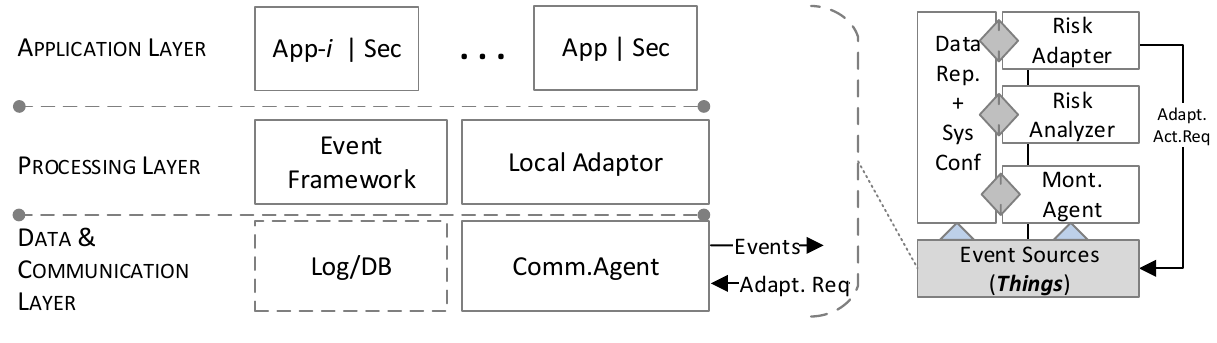
Figure 4. Event source